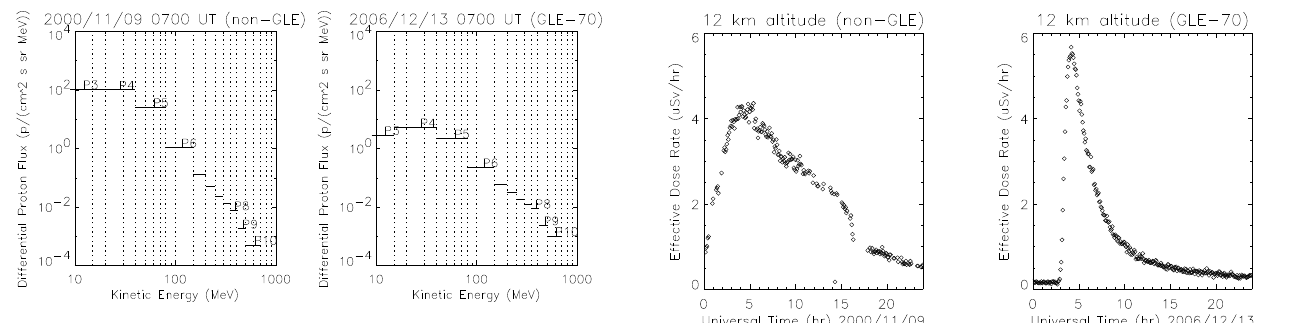
Figure 3. Simulated effective dose rate at 12km altitude at the polar region during the non-GLE SEP event (left) and during the GLE-70 event